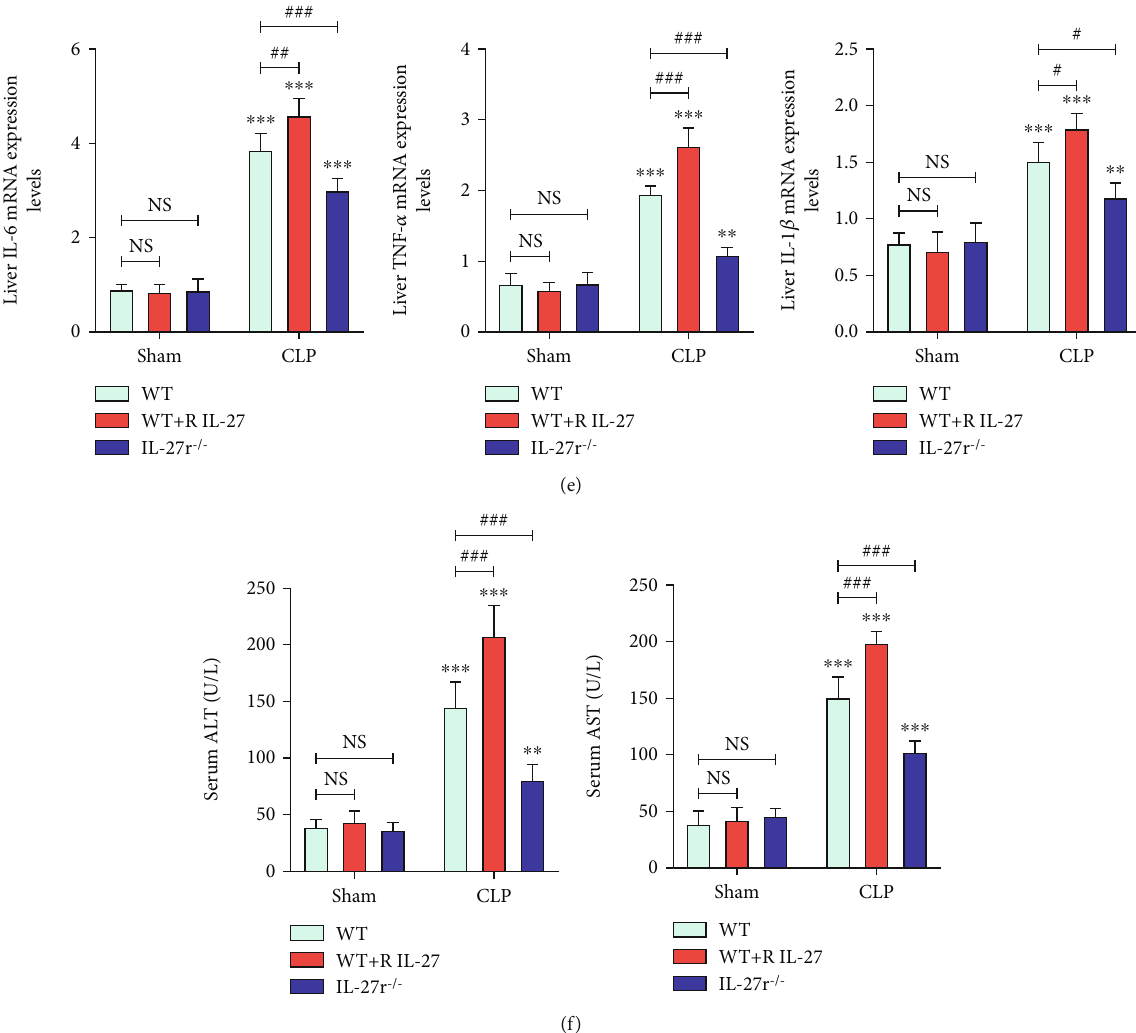
Figure 1: (a) Serum IL-27 levels of sham WT mice (Sham) and WT mice after CLP (CLP) (by ELISA), ∗∗∗ p < 0 : 001 . (b) EBI3 and P28 mRNA levels in the liver tissue of sham WT mice (Sham) and WT mice after CLP (CLP) (by qPCR), ∗∗∗ p < 0 : 001 . (c) EBI3 and P28 protein levels in the liver tissue of sham WT mice (Sham) and WT mice after CLP (CLP) (by Western blot), ∗∗∗ p < 0 : 001 . (d) Hematoxylin and eosin- (H&E-) stained liver tissues and histological scores for the liver from WT, WT+recombinant IL-27 (R IL-27) pretreatment, and IL-27r -/- mice ( n = 5 per group) (sham and after CLP) ( × 200, × 400 magni fi cations), ∗∗ p < 0 : 01 , ∗∗∗ p < 0 : 001 vs sham group; NS: p > 0 : 05 , # p < 0 : 05 , ## p < 0 : 01 . (e) IL-6, TNF- α , and IL-1 β mRNA levels in the liver tissue (by qPCR) of WT, WT+recombinant IL-27 (R IL-27) pretreatment, and IL-27r -/- mice (sham and after CLP), ∗∗ p < 0 : 01 , ∗∗∗ p < 0 : 001 vs sham group; NS: p > 0 : 05 , # p < 0 : 05 , ## p < 0 : 01 , ### p < 0 : 001 . (f) Serum ALT and AST levels of WT, WT+recombinant IL-27 (R IL-27) pretreatment, and IL-27r -/- mice (sham and after CLP). ∗∗ p < 0 : 01 , ∗∗∗ p < 0 : 001 vs sham group; NS: p > 0 : 05 , ### p < 0 : 001